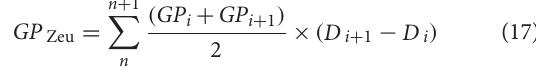
′ ′ ′ ′ concurrently showed an /F , and F /F v q m q